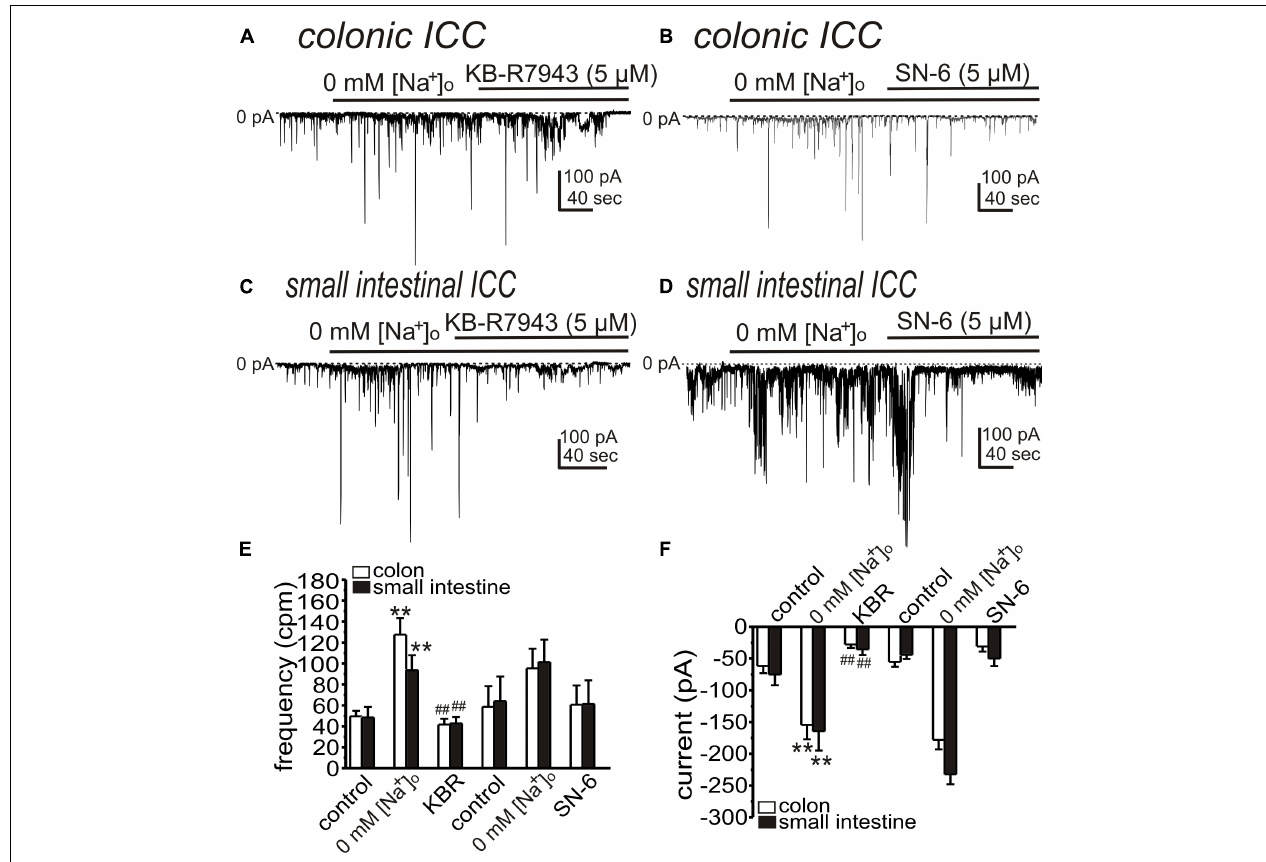
FIGURE 5 | KB-R7943 and SN-6 inhibit STICs activated by low [Na + ] o . Cells were held at –80 mV and STICs occurred spontaneously. (A,B) Representative traces showing that KB-R7943 (5 µ M) and SN-6 (5 µ M) inhibited STICs activated by 0 mM [Na + ] o (Solution II) in colonic ICC. (C,D) Representative traces showing that KB-R7943 (5 µ M) and SN-6 (5 µ M) inhibited STICs activated by 0 mM [Na + ] o in small intestinal ICC. Dotted lines denote 0 pA. (E,F) Summary data showing the effects of low [Na + ] o and Ano1 blockers on the frequency (D) and amplitude (E) of STICs. ** p < 0.01 vs. control; ## p < 0.01 vs. low [Na + ] o